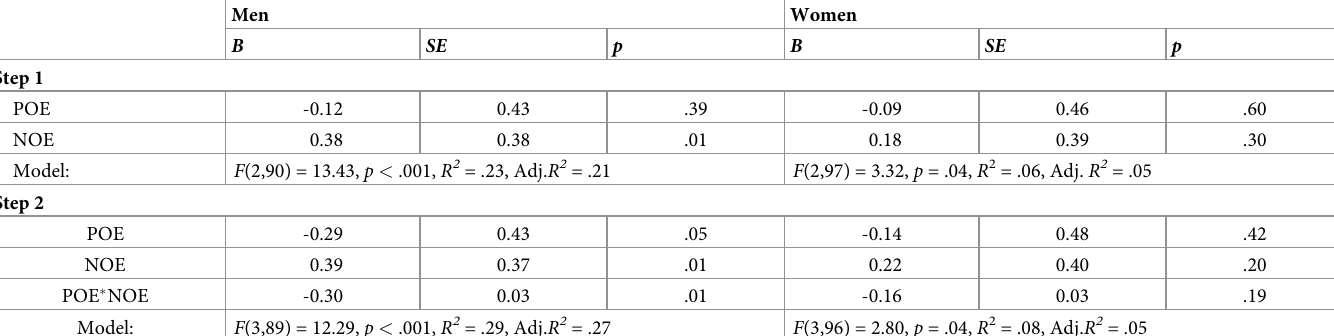
Table 3. Sex-specific models predicting harassment perception using positive outcome expectancies, negative outcome expectancies, and their interaction.